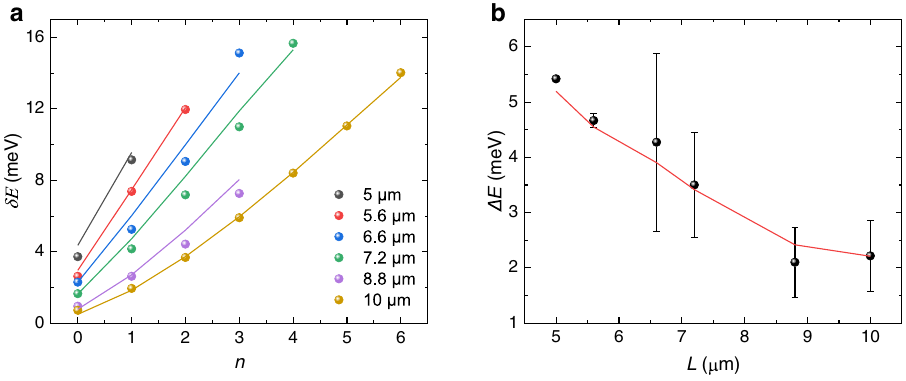
Fig. 2 | Dependence of quantised states on pump separations. a Extracted relative mode energies δ E versus quantum number n for multiple separations between two pump spots. Solid circles and lines represent experimental and